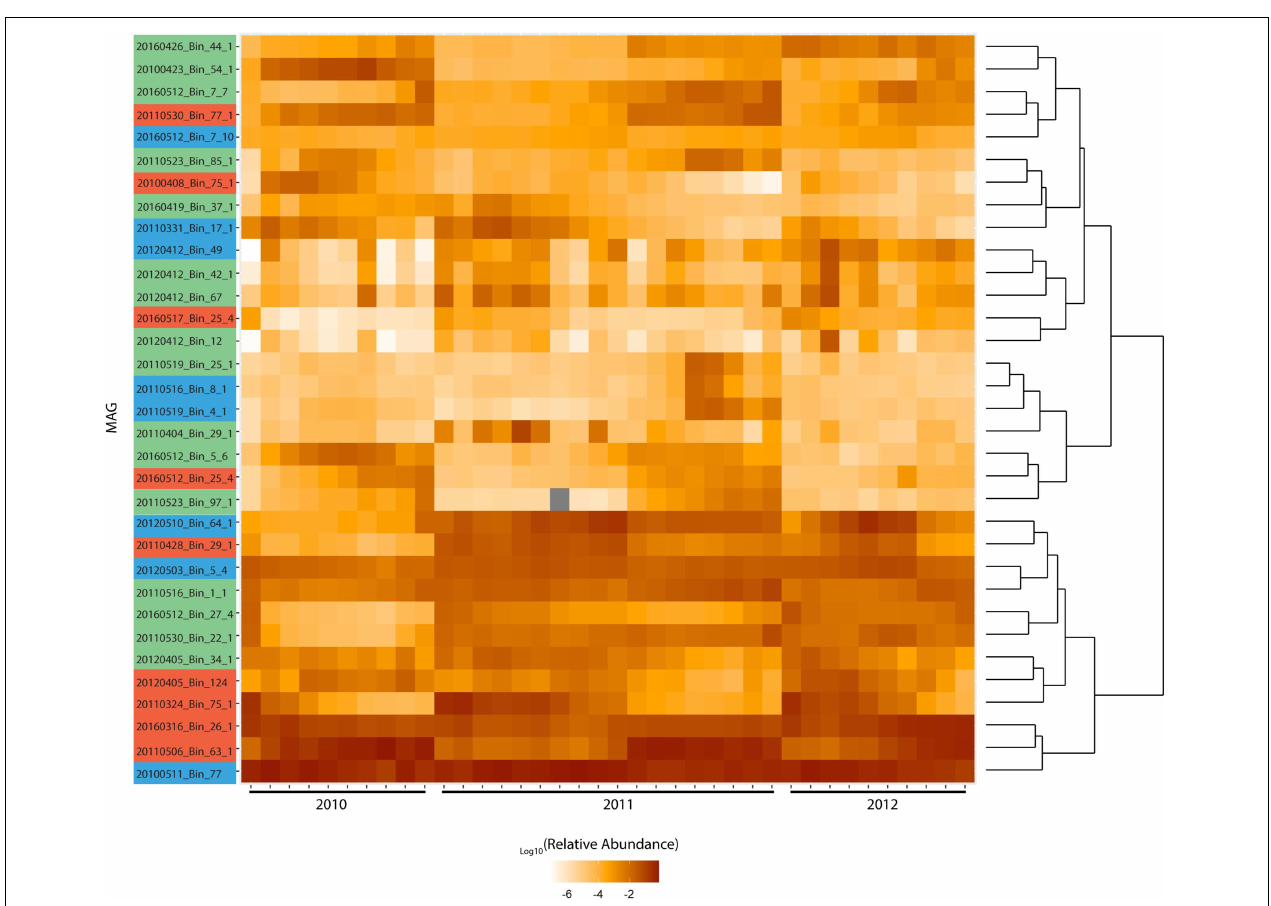
FIGURE 4 | Log relative abundance of Rhodobacterales MAGs during blooms across 2010-2012. Color coding of MAG names indicate the MAG grouping based on Figure 3 . Metagenome raw reads were mapped to these MAGs at 97% identity. Cells with gray shading indicate values that are zero. Read counts were normalized against MAG length and the relative abundance calculated. Hierarchical clustering was performed in and visualized with R 3.6.1 using ggplot2. Distance method: canberra and hierarchical clustering method: ward.D2 were used. Upper cluster represents MAGs with fluctuating abundance while lower cluster represents MAGs with consistently high abundance throughout